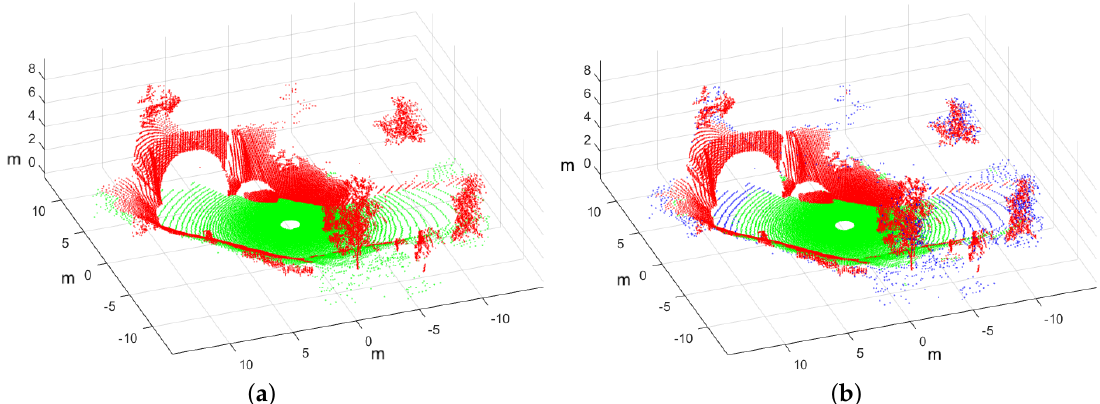
Figure 5. The validation scan at the entrance of the cave ( a ) and the prediction results with RF ( b ).